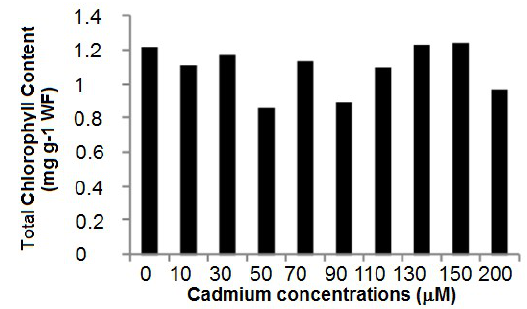
Fig. 9 . Effects of cadmium on total chlorophyll content of Brassica napus L.